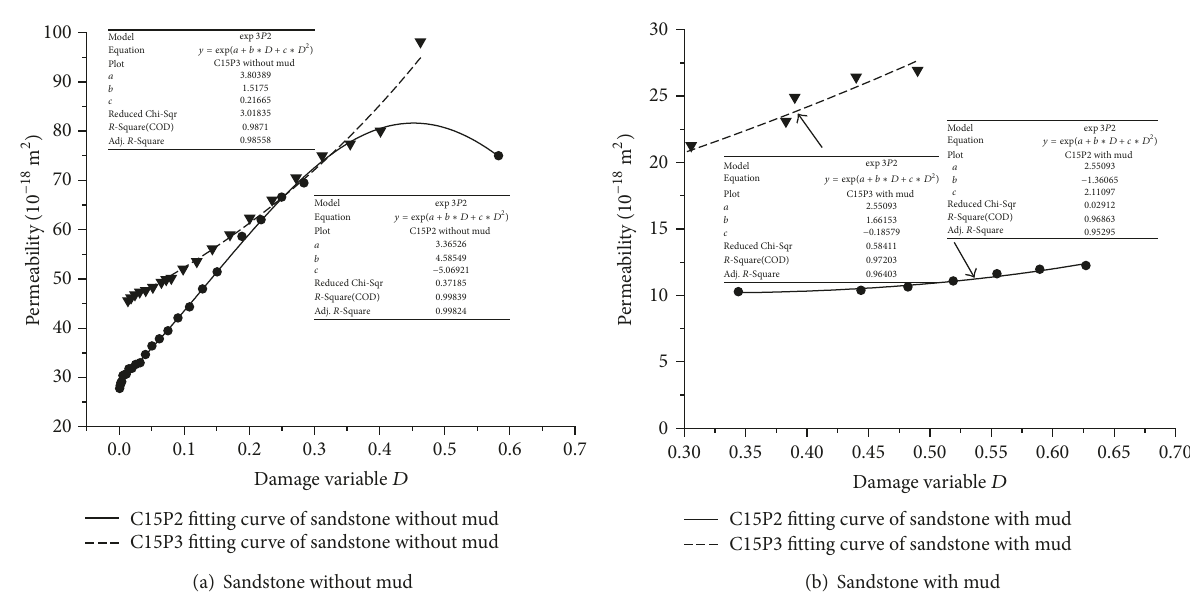
Figure 9: The relationship of damage variable and circumferential crack strain.